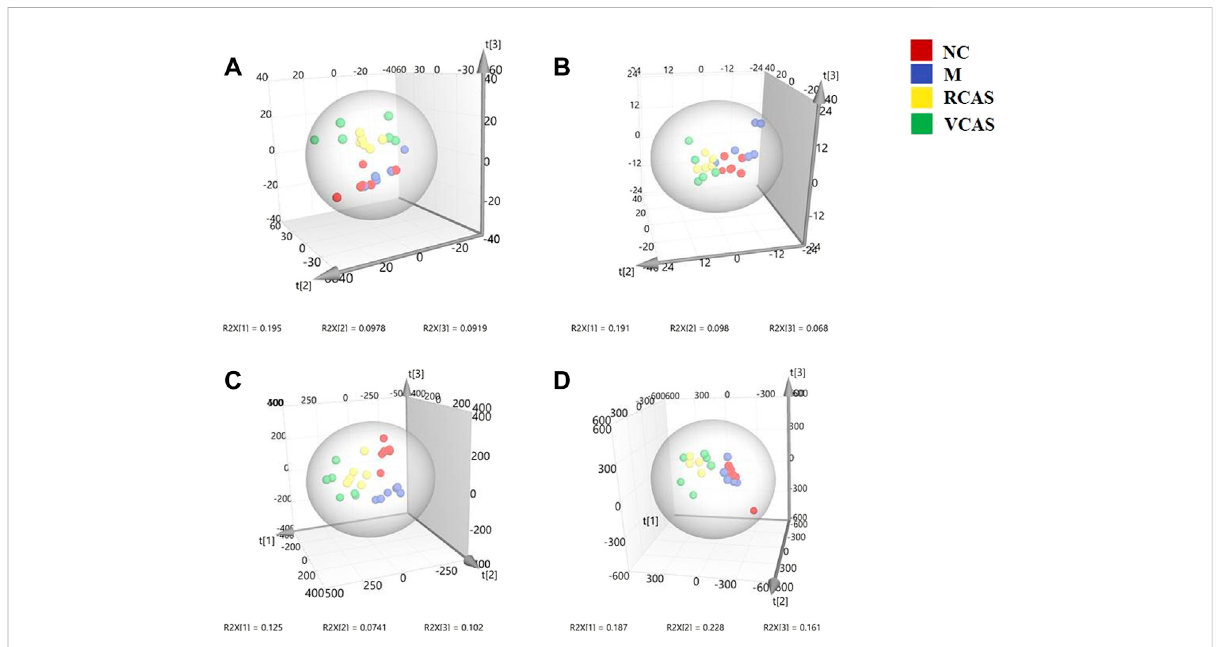
FIGURE 6 PCAandPLS-DA3D-scorescatterplotofUPLC-Q-TOF/MSdatafromurinesamples. (A) PCA3D-scorescatterplotinthepositiveionmode; (B)